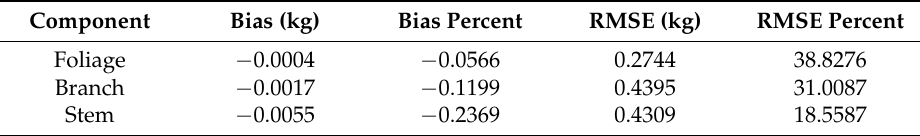
Table 8. Bias and root mean squared error obtained from multinomial logistic